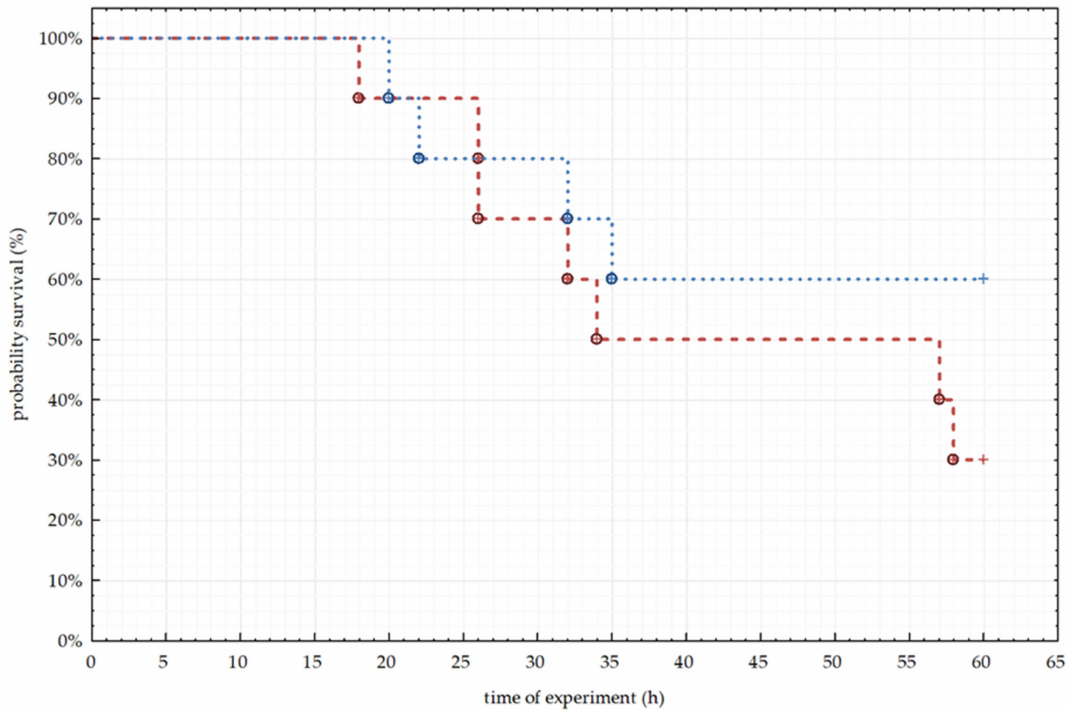
Figure 5. Percentage of rabbit survival recorded for the two tested strains ( L. europaeus / GI.1a / Erfurt and L. europaeus / GI.1a / Rossi), analyzed by Kaplan–Meier